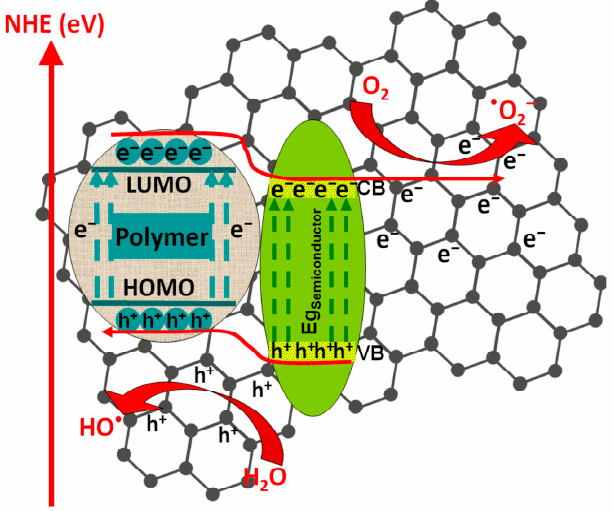
Figure 6. Polymer/semiconductor/GO composites with photocatalytic applications. Polyether tetraacrylate was used to form composites with Nd 0.9 TiO 3 and LaTiO 3 for acid black dye removal from a 15 mg/L aqueous solution [89]. The photocatalytic efficiency was similar for both composites (94% for polyether tetraacrylate /Nd 0.9 TiO 3 and 95% for polyether tetraacrylate/LaTiO 3 ) after 30 min of exposure to UV light with 250 mW/cm 2 irra- diance. Titanate perovskites are thermically stable materials with remarkable high corrosion resistance, which makes them suitable candidates for acidic environmental